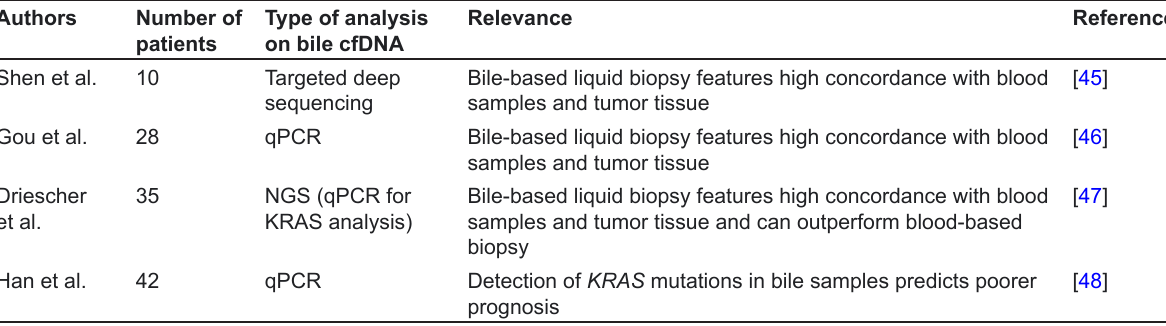
Explor Target Antitumor Ther. 2022;3:362–74 |